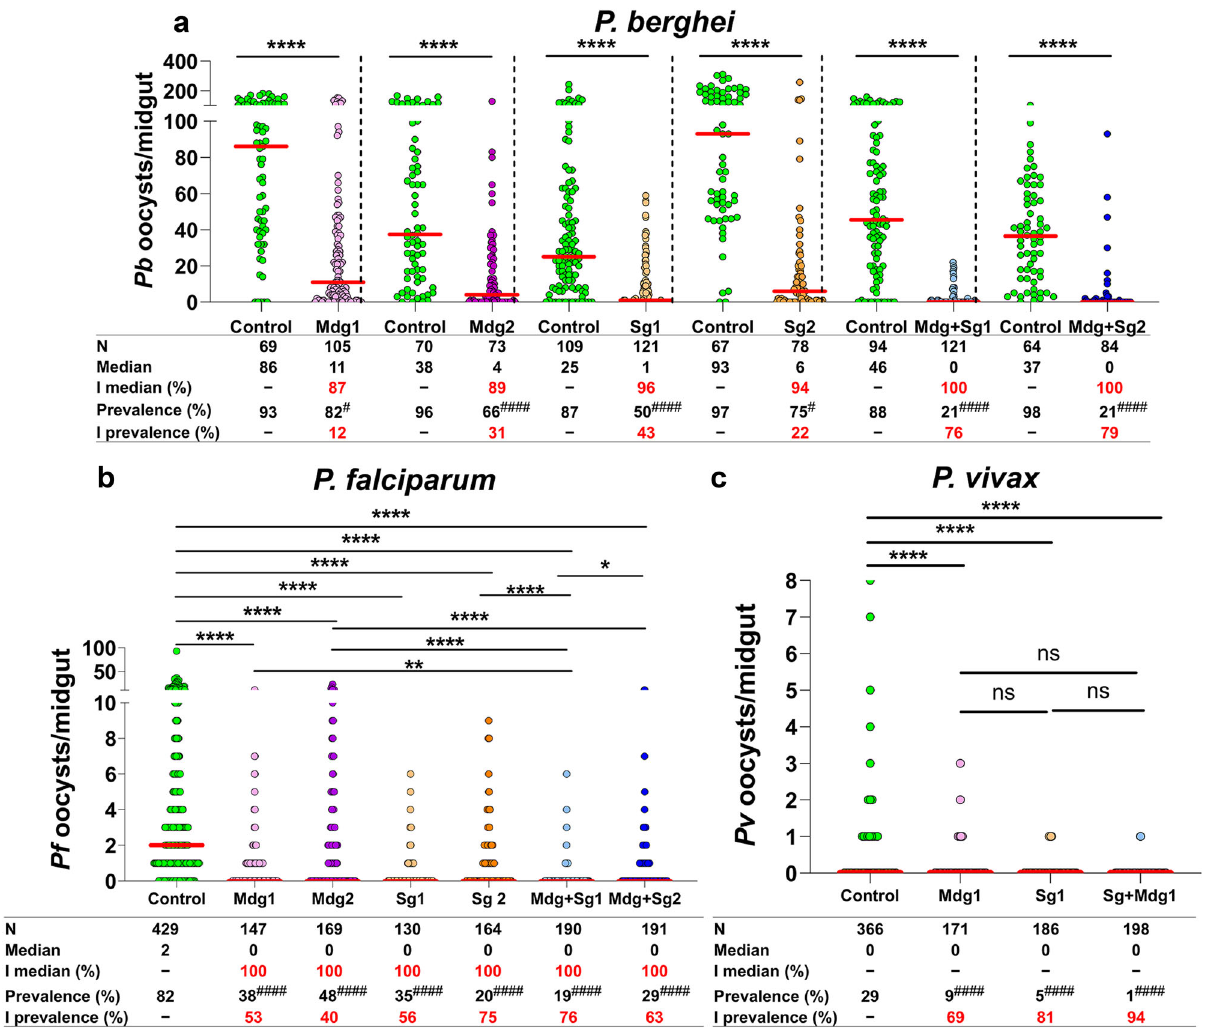
Fig. 4 huPAI-1 expression strongly inhibits P. berghei , P. falciparum , and P. vivax oocyst formation. Oocyst numbers were determined in transgenic and control mosquitoes infected with P. berghei after feeding on infected mice ( a ), P. falciparum by standard membrane feeding assay (SMFA) ( b ), and P. vivax by direct feeding on infected monkeys ( c ). Control experiments were done with either WT mosquitoes or the parental lines SgD1, SgD2, or QUAS2 (Supplementary Data 1, Datasets 3 – 5). P. falciparum SMFAs were performed with gametocyte-infected RBCs supplemented with plasma. Horizontal red lines represent the median oocyst number of data pooled from at least three independent experiments shown in Supplementary Data 1, Datasets 3 –